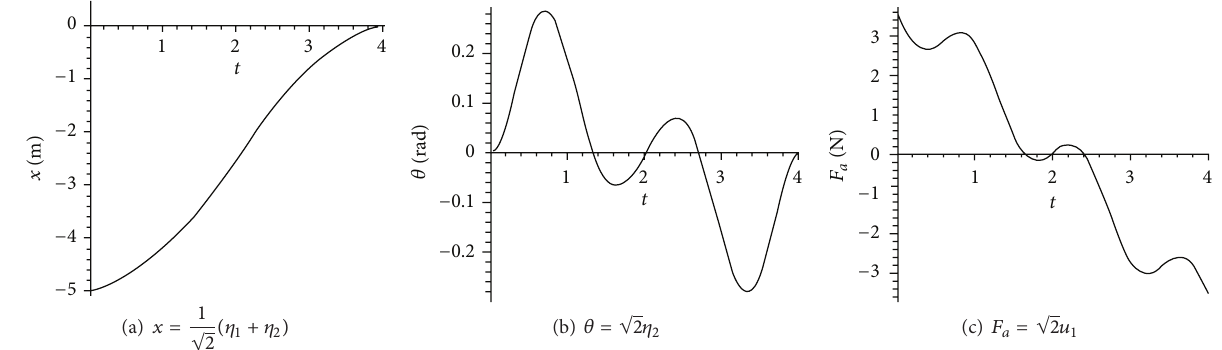
Figure 2: Histograms of (a) cart trajectory 𝑥 , (b) swing angle 𝜃 , and (c) force 𝐹 𝑎 (open